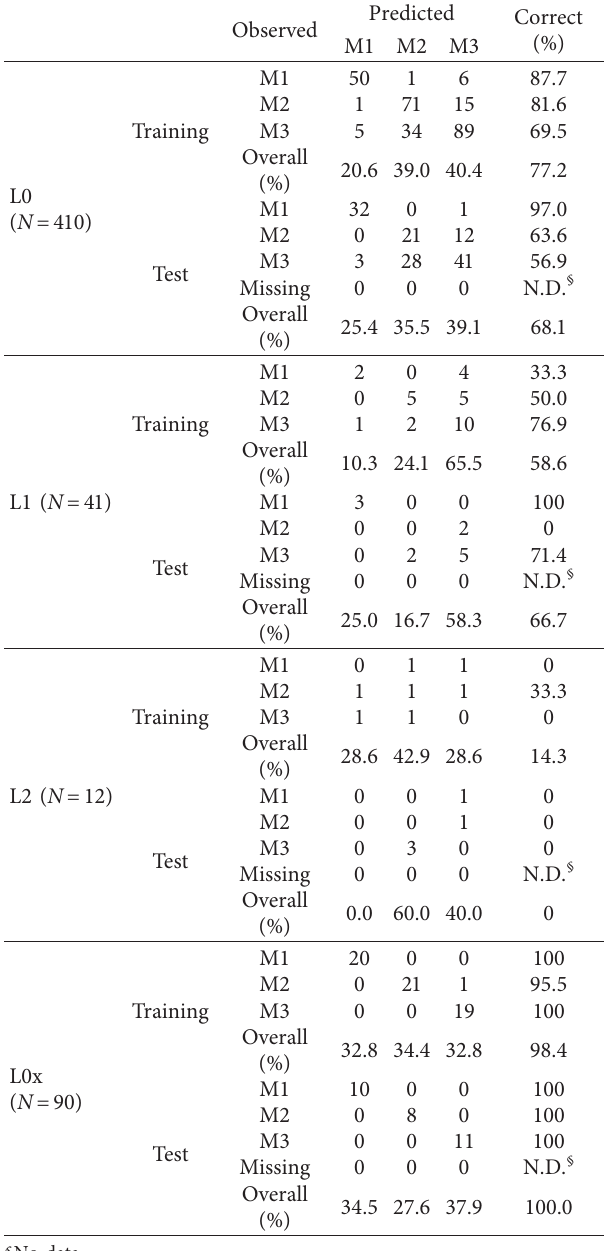
Table 7: The prediction results using the kNN method for each